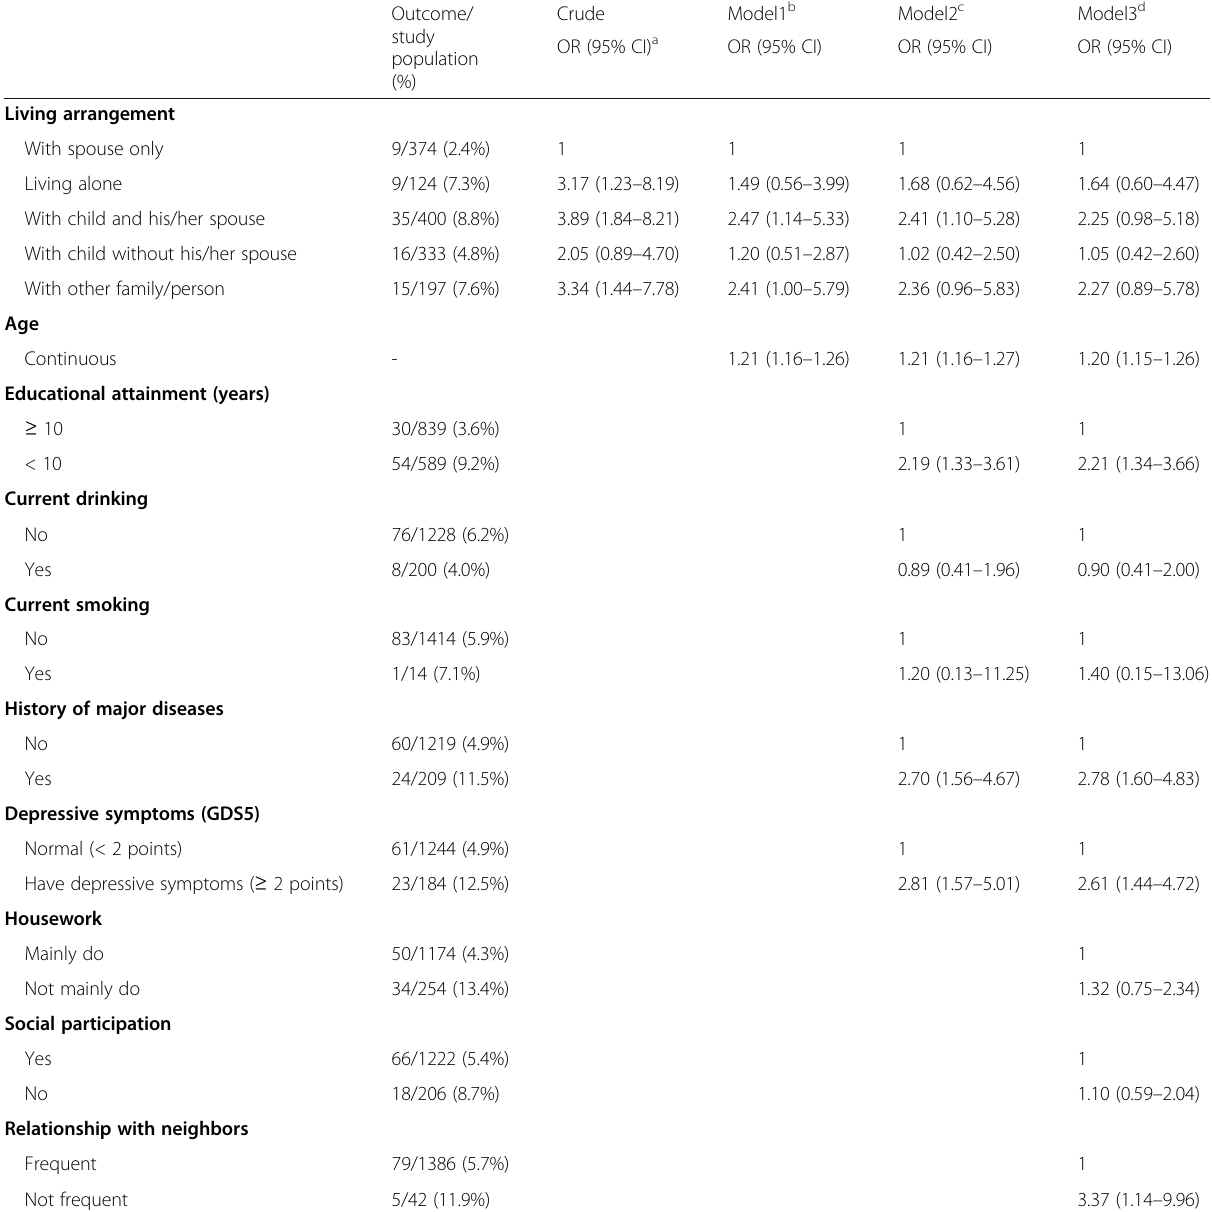
Table 3 Association between living arrangement and decline in functional capacity after three years for women ( n =